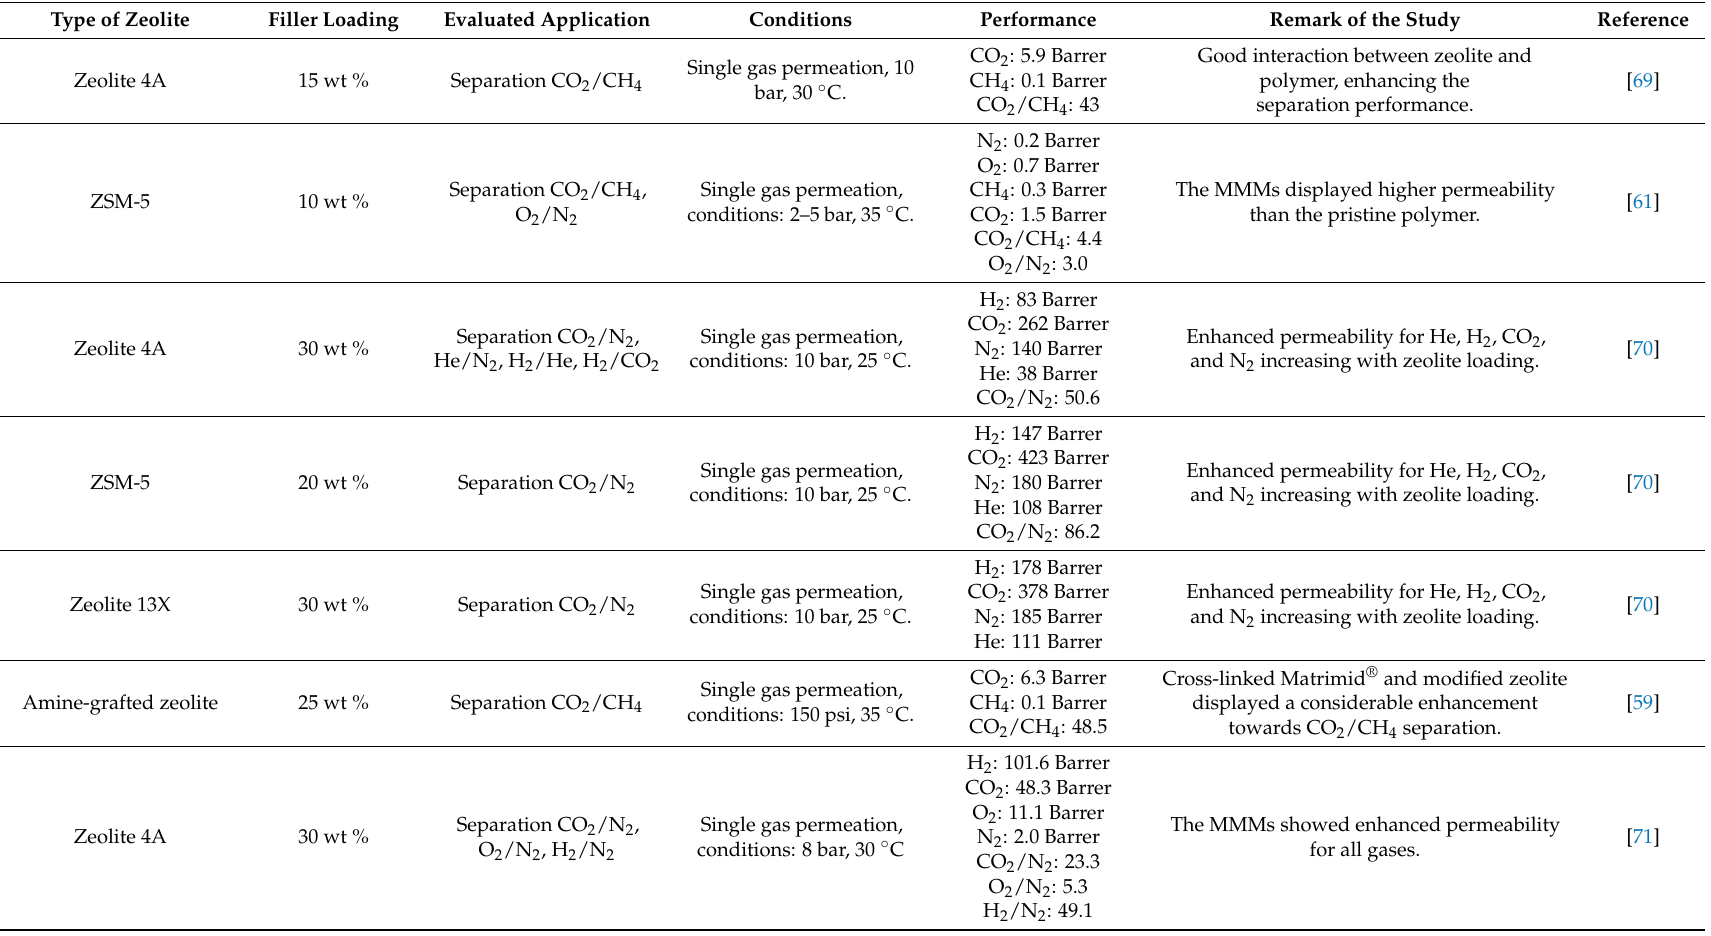
Table 4. Zeolite materials incorporated into Matrimid ® for gas separation